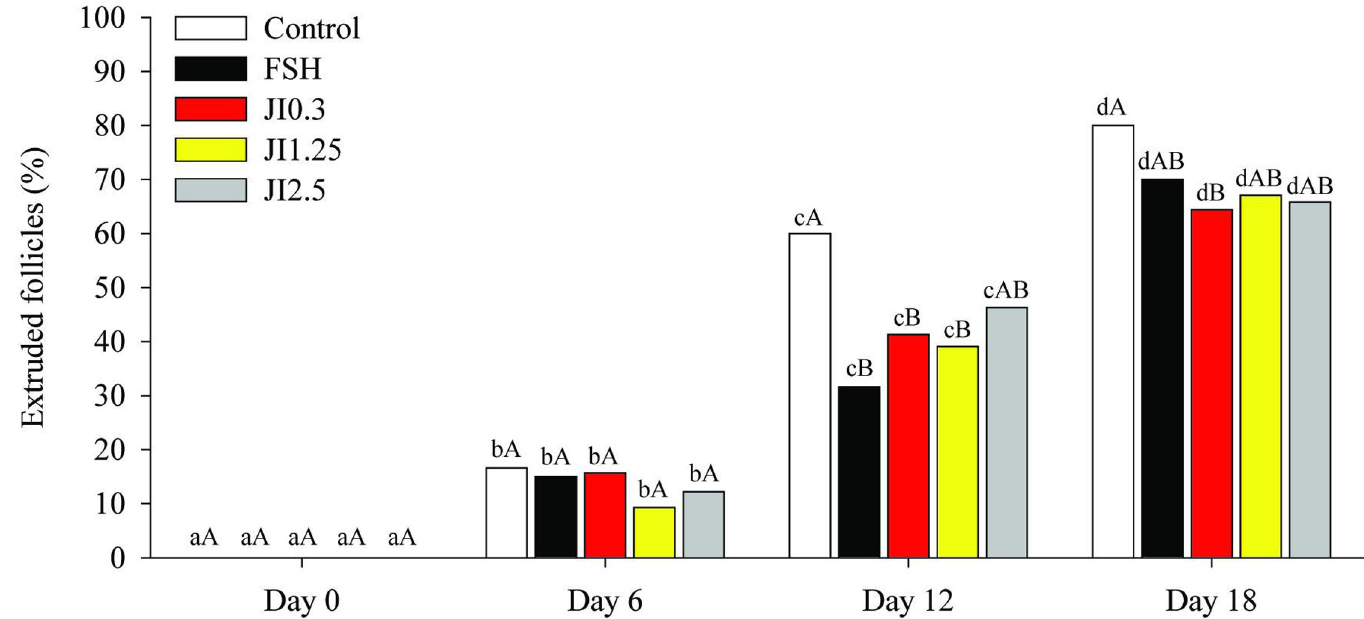
Fig 5. Percentage of extrusion at different time point (D0, D6, D12, D18) in MEM + (Control), FSH or in J . insularis 0.3, 1.25 or 2.5 mg/mL (JI0.3, JI1.25 or JI2.5 respectively). D: day, MEM + : Minimal essential medium supplemented, FSH: recombinant bovine follicle stimulating hormone, JI: J . insularis . A total of 342 secondary follicles were distributed in the different treatments (n = 6 replicates). a,b,c,d Different letters denote significant differences among time for a given treatment group (P < 0.05). A,B Different letters denote significant differences among treatment groups within the same time point (P < 0.05).